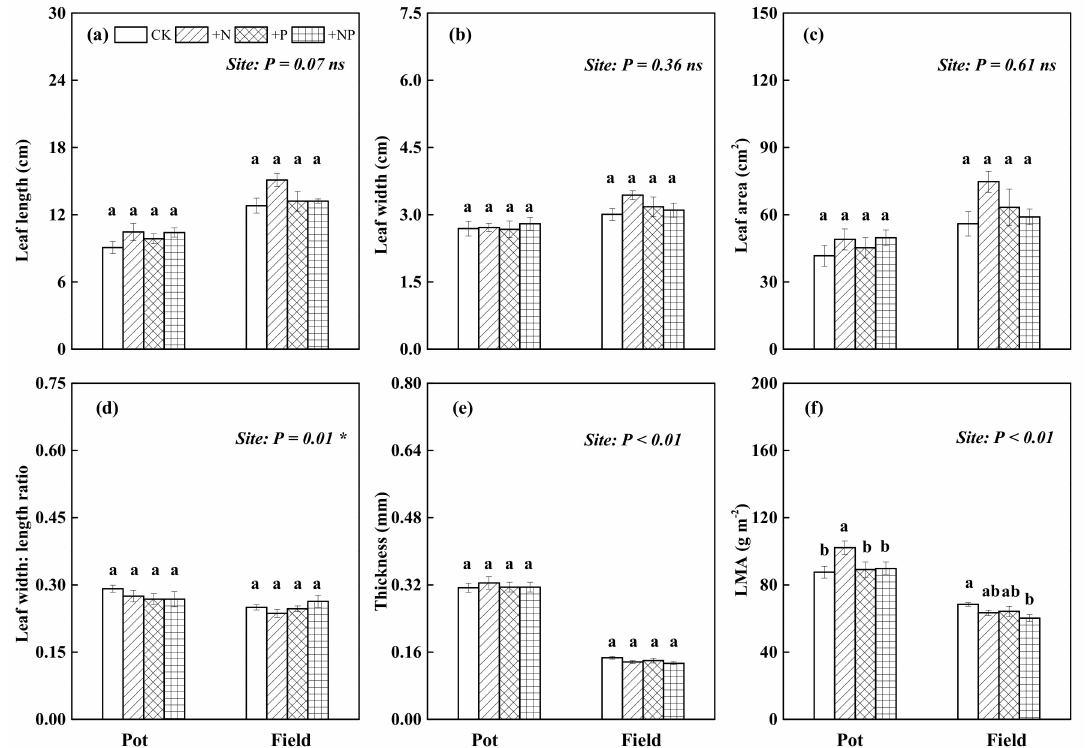
Figure 2. Leaf length ( a ), width ( b ), area ( c ), width:length ratio ( d ), thickness ( e ), and leaf mass per area (LMA) ( f ) of Schima superba under field and pot experimental nitrogen and phosphorus addition (CK = control, +N = nitrogen addition, +P = phosphorus addition, +NP = nitrogen plus phosphorus addition). Note: The bars indicate the standard error. The small letters indicate the differences ( p < 0.05) among the four treatments within field or pot experiments. The p value indicates the difference ( p < 0.05, *) between field and pot experiments. The bars indicate standard errors (field, n = 3; pot, n =